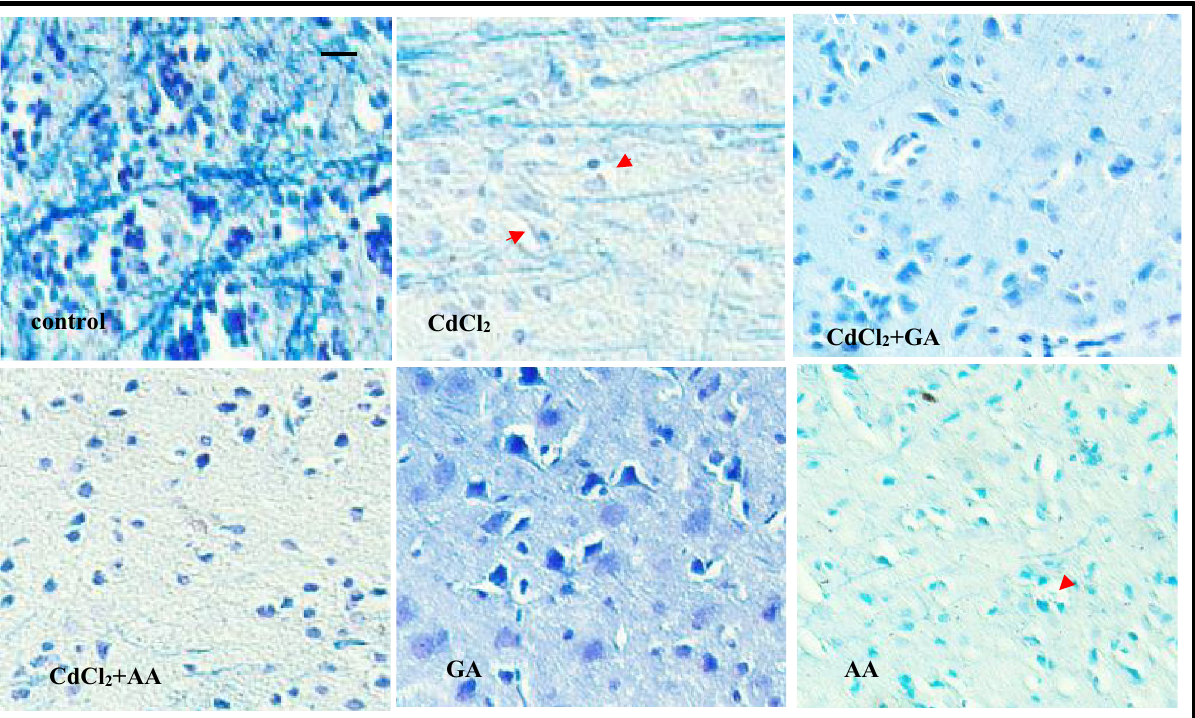
Figure 9. Representative images of Luxol fast blue staining of subcortical white matter of experimental rat showing the myelin density of the tract. Red arrowheads indicate vacuolation within the white matter. Note: the pale staining intensity in the CdCl 2 and AA groups compared to other groups. GA gallic acid, AA ascorbic acid (scale bar = 50